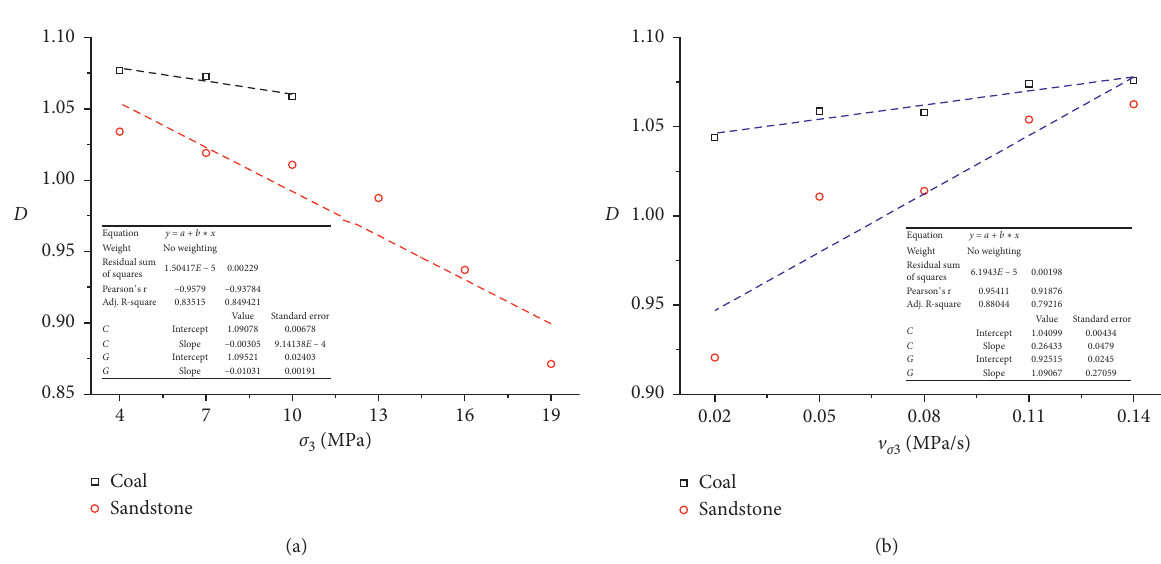
Figure 7: Effects of the unloading conditions on the fractal dimension of surface cracks. (a) Fractal dimension with different initial unloading confining pressures. (b) Fractal dimension with different unloading